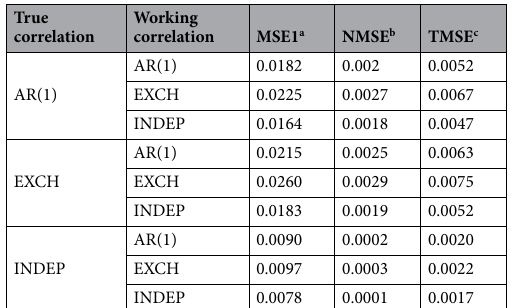
True correlation